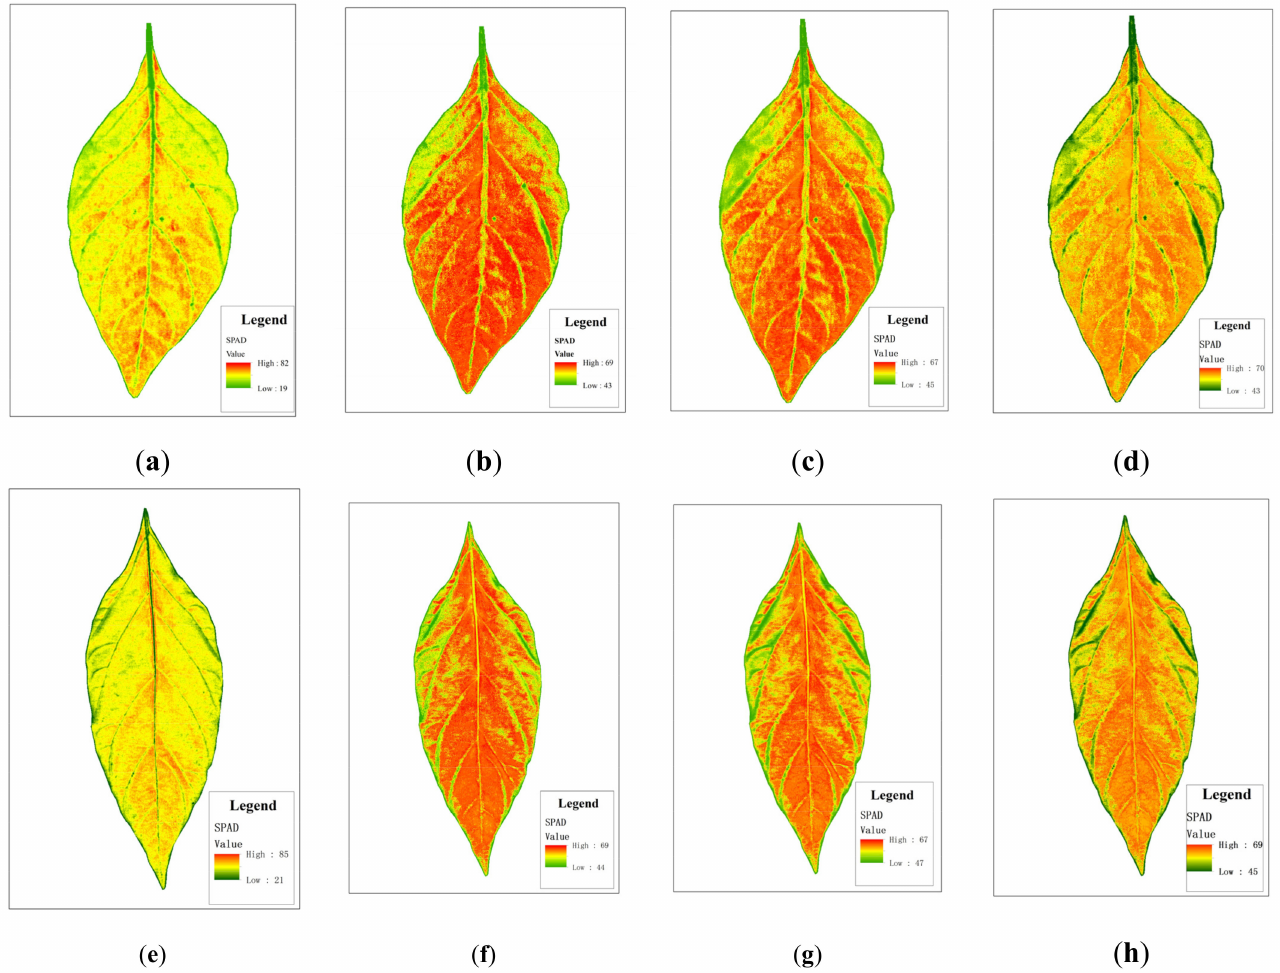
Figure 11. Distribution of SPAD value in the lower leaf in different models: ( a , e —PLSR), ( b , f —XGBoost), ( c , g —RFR), ( d , h